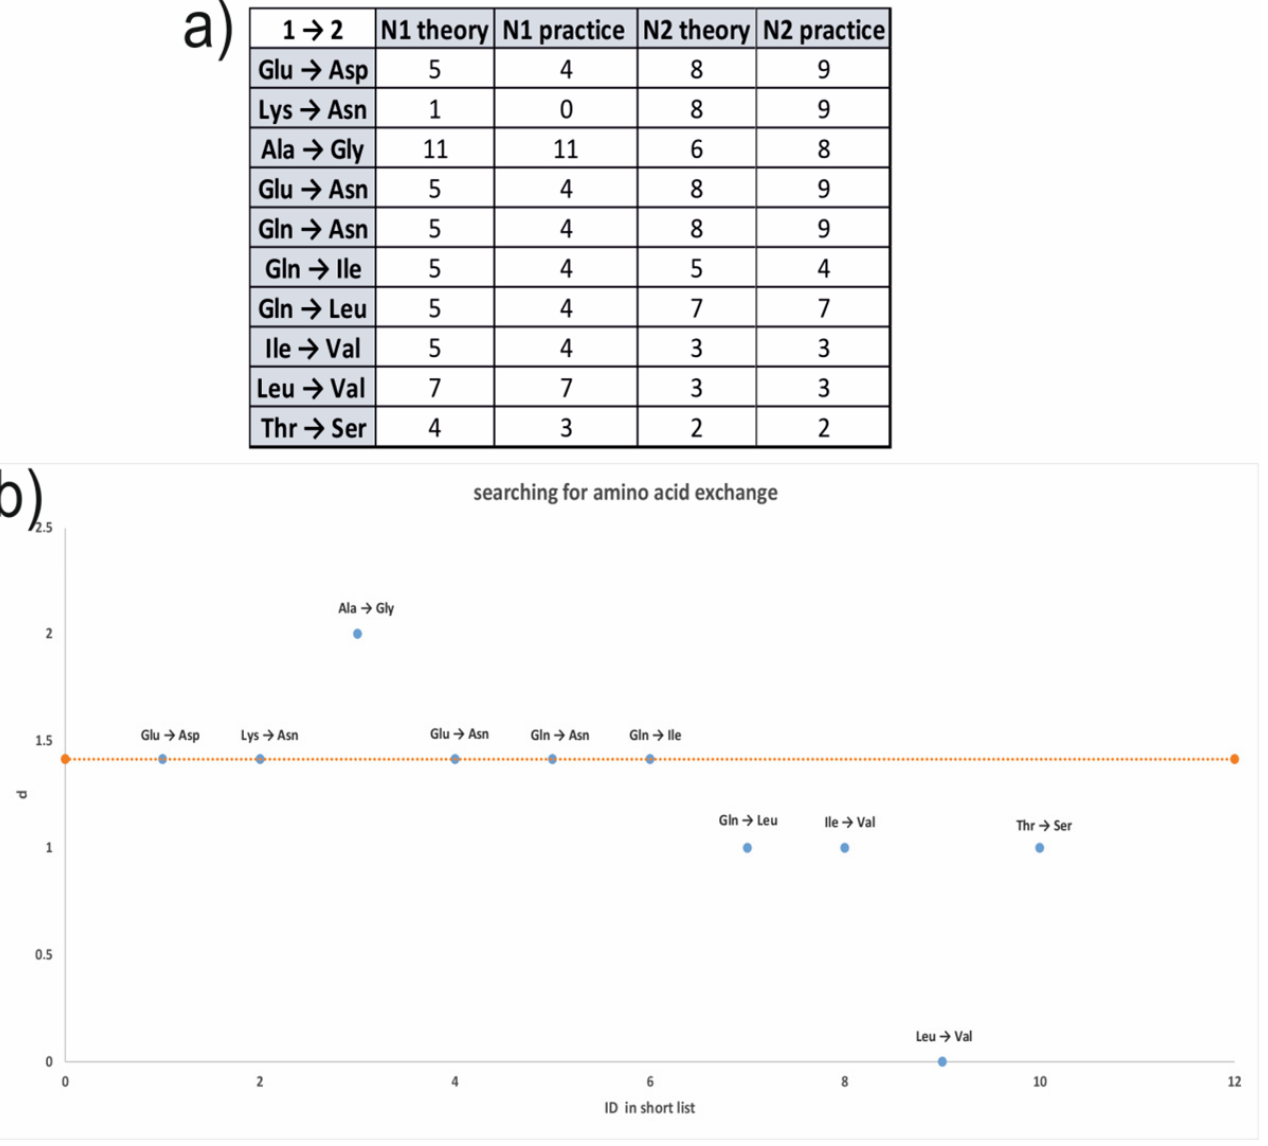
Figure 5. Amino acid change research over the amino acid analysis results. ( a ) A table including all of the possible amino acid changes, where the initial amino acid, “1” (presented in the annotated sequence), changed to another one, “2” (presented in the results of research). N 1 and N 2 are the numbers of corresponding amino acids. ( b ) The d function plot is depicted. Each amino acid change is displayed on the plot with the calculated meaning of the d function. The d function value, related to the normal proportion of a one-letter change in the protein, is marked on the plot as a yellow dotted straight